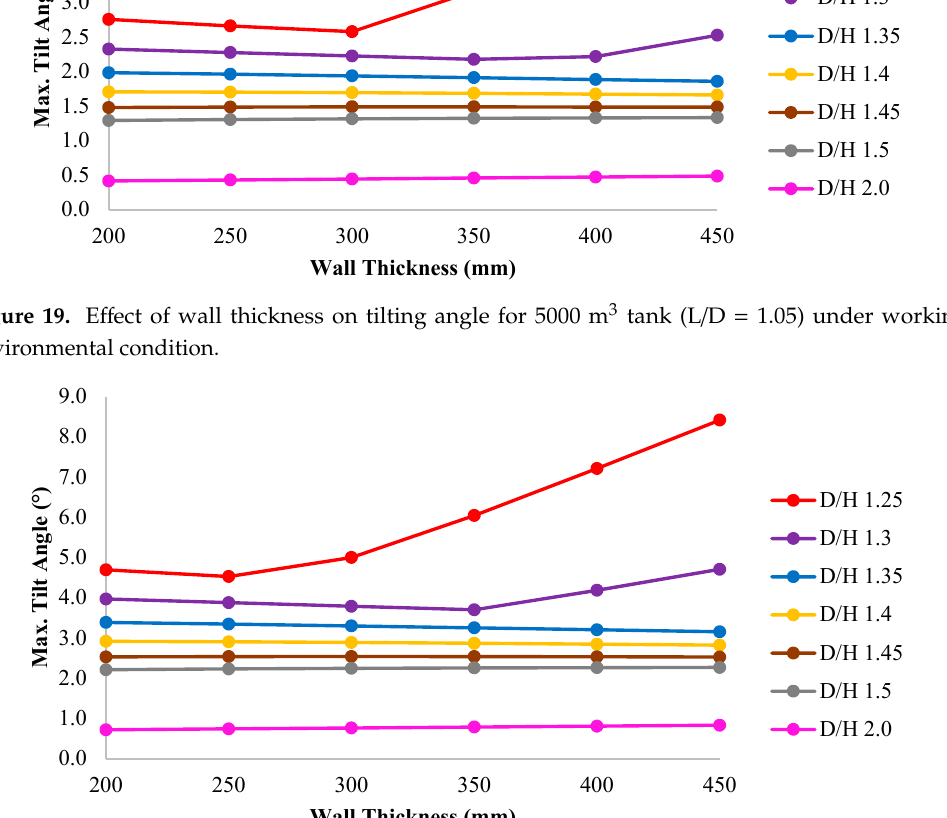
Figure 20. Effect of wall thickness on tilting angle for 5000 m 3 tank (L/D = 1.05) under extreme environmental condition.